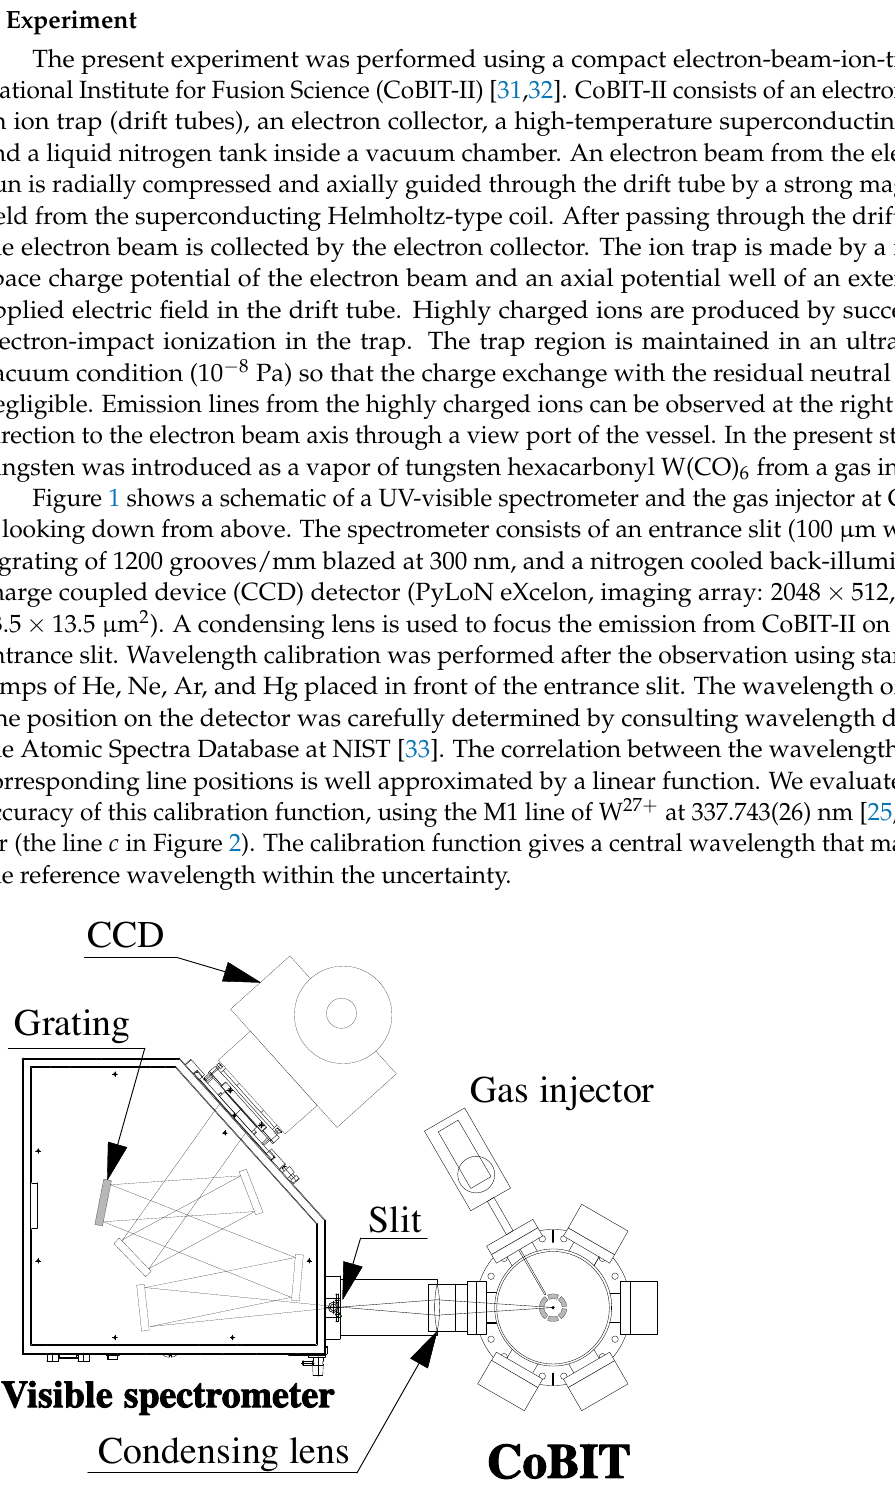
Figure 1. Schematic of the UV-visible spectrometer and the gas injector at the compact electron-beam- ion-trap in the National Institute for Fusion Science